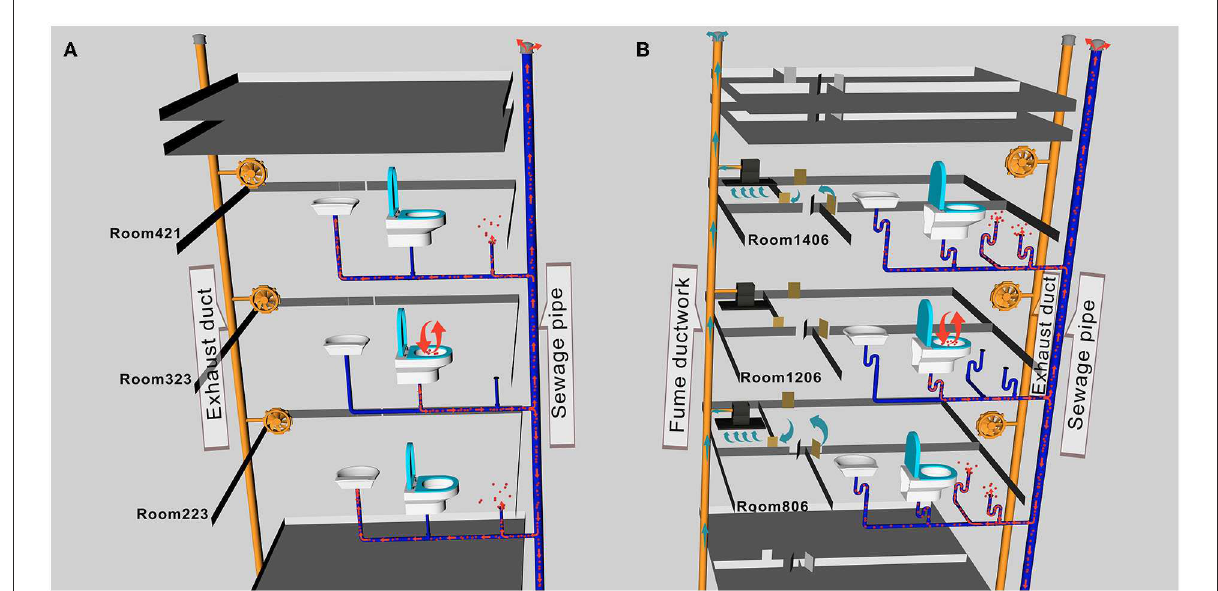
FIGURE2 A schematic diagram of aerosol transport pathways in buildings (A, B) . (A) Viral aerosol simulants entered each bathroom through the path of “excretion of virus through feces-toilet flushing-sewage pipe-floor drain without a water seal.” (B) The path of viral aerosol simulant entered